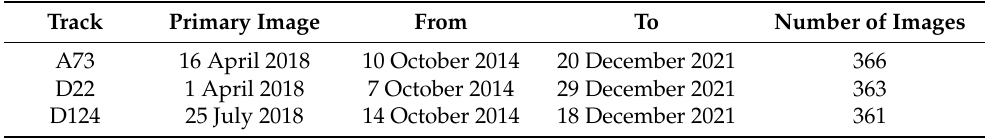
Table 1. Sentinel-1 mission data used in this study. Track Primary Image From To Number of